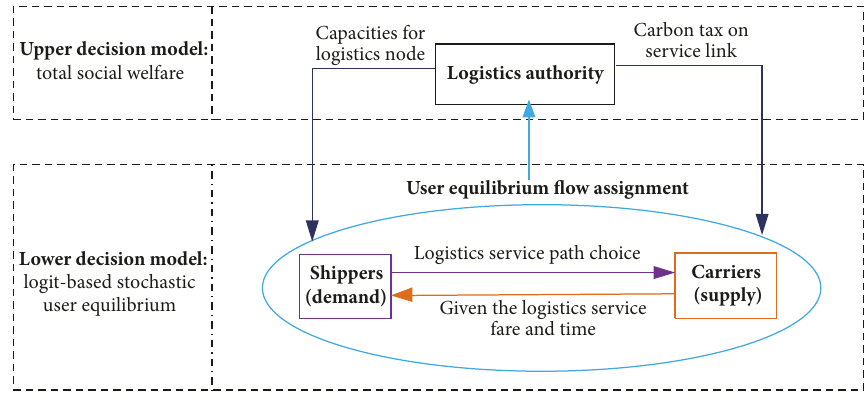
Figure 2: Decision framework of green logistics